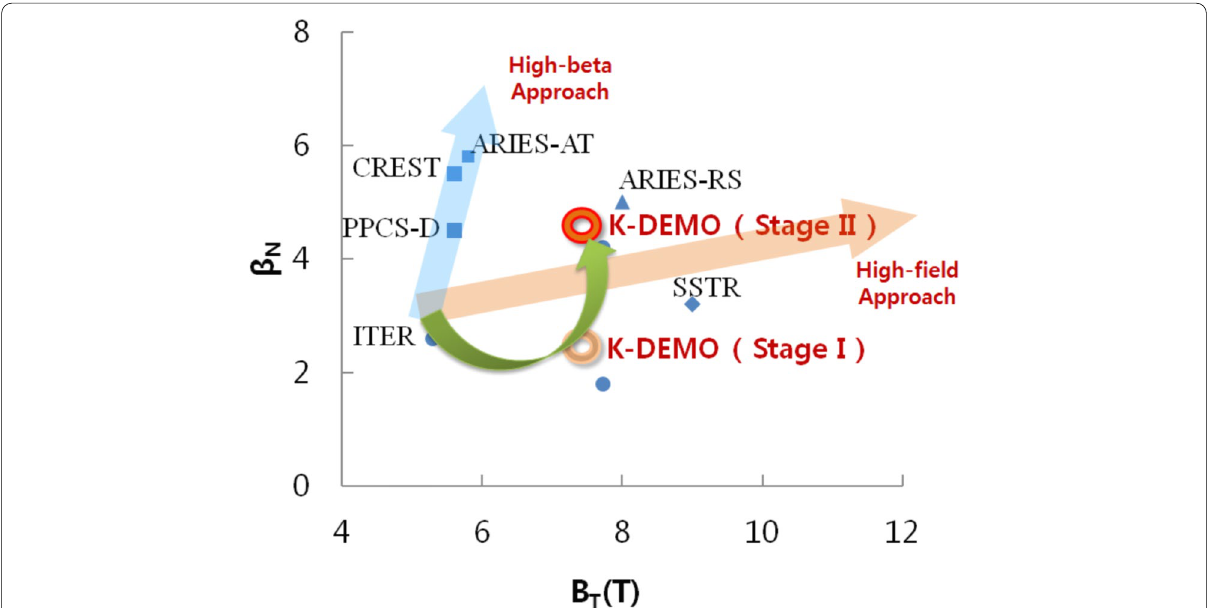
Fig. 2 Two‑phased approach in K‑DEMO development in Korea [37,